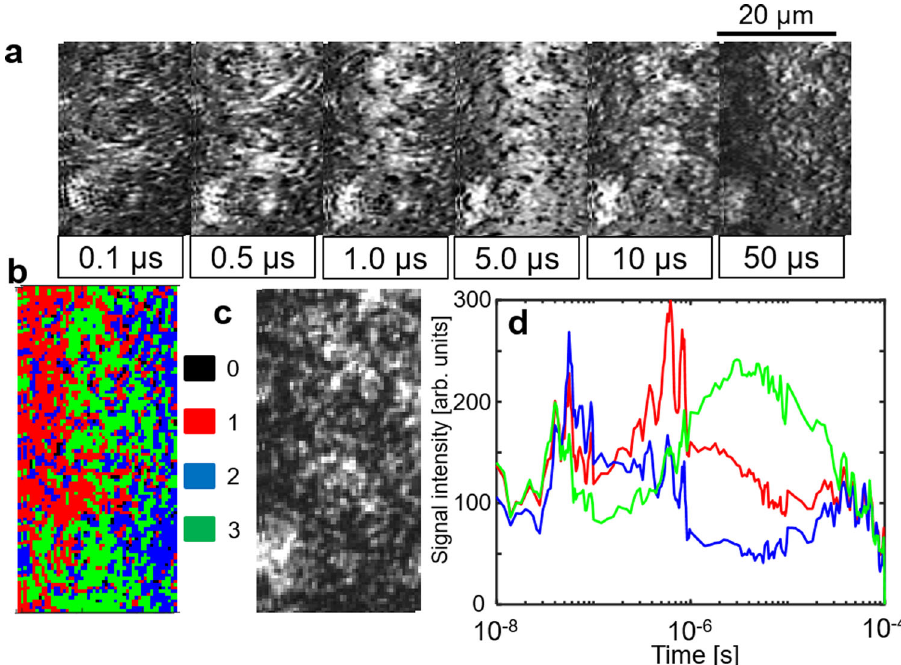
Fig. 5 Image sequence and clustering analysis without mediator. a An image sequence of the refractive index response for SrTiO 3 :Rh/BiVO 4 :Mo STOR/ BVOM in acetonitrile (ACN) in a square region (18 × 50 μ m) corresponding to no.1 in Fig. 1c on the order from nanoseconds to microseconds. The scale bar corresponds to 20 µ m. b The categorized mapping of the charge carrier responses of a . An outlier positioned far from all categories was colored in black (#0). c A microscopic image in the same area as a . d The averaged responses for each category in b are shown. (red: category 1, blue: category 2, green: category